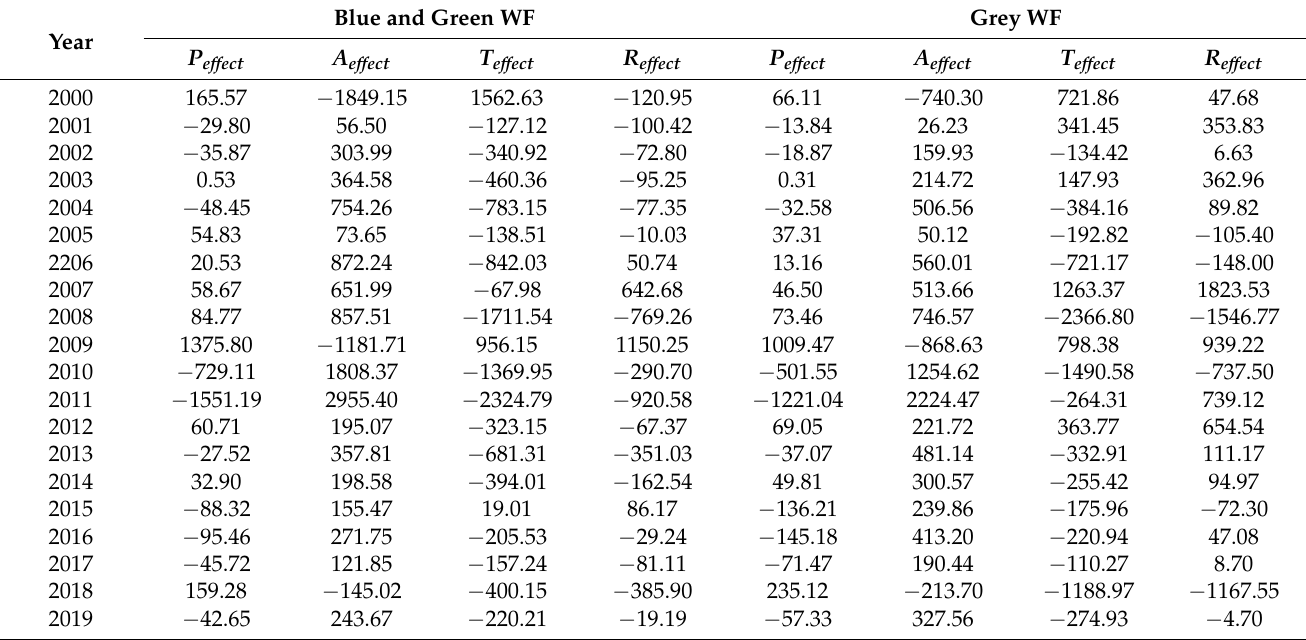
Table 3. The various effects on water footprint in Yangling from 1999 to